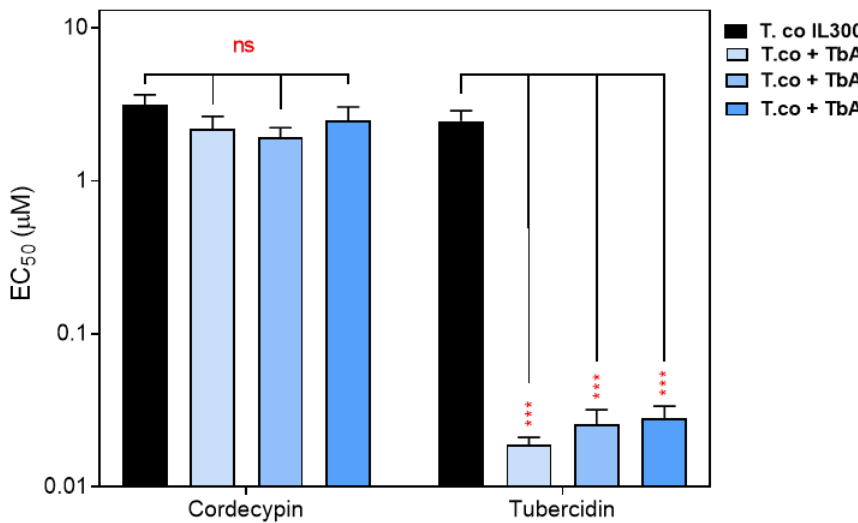
Figure 10. Effect of expression of TbAT1 on the sensitivity of T. congolense to tubercidin. Sensitivity is represented as average EC 50 (mean ± standard error of mean) of three independent determinations. *** p < 0.001; ns = not significant by unpaired Student’s t -test.